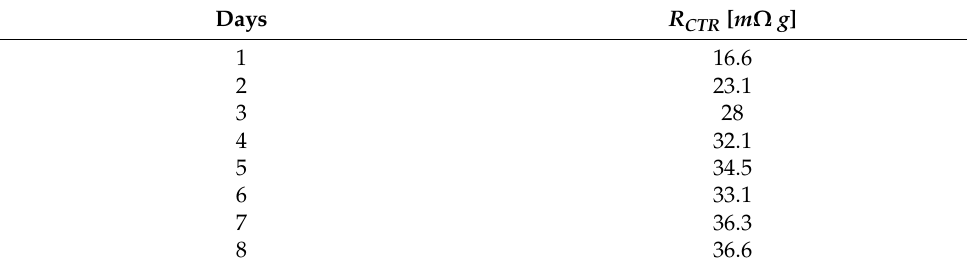
Table 2. Charge transfer resistance by the number of